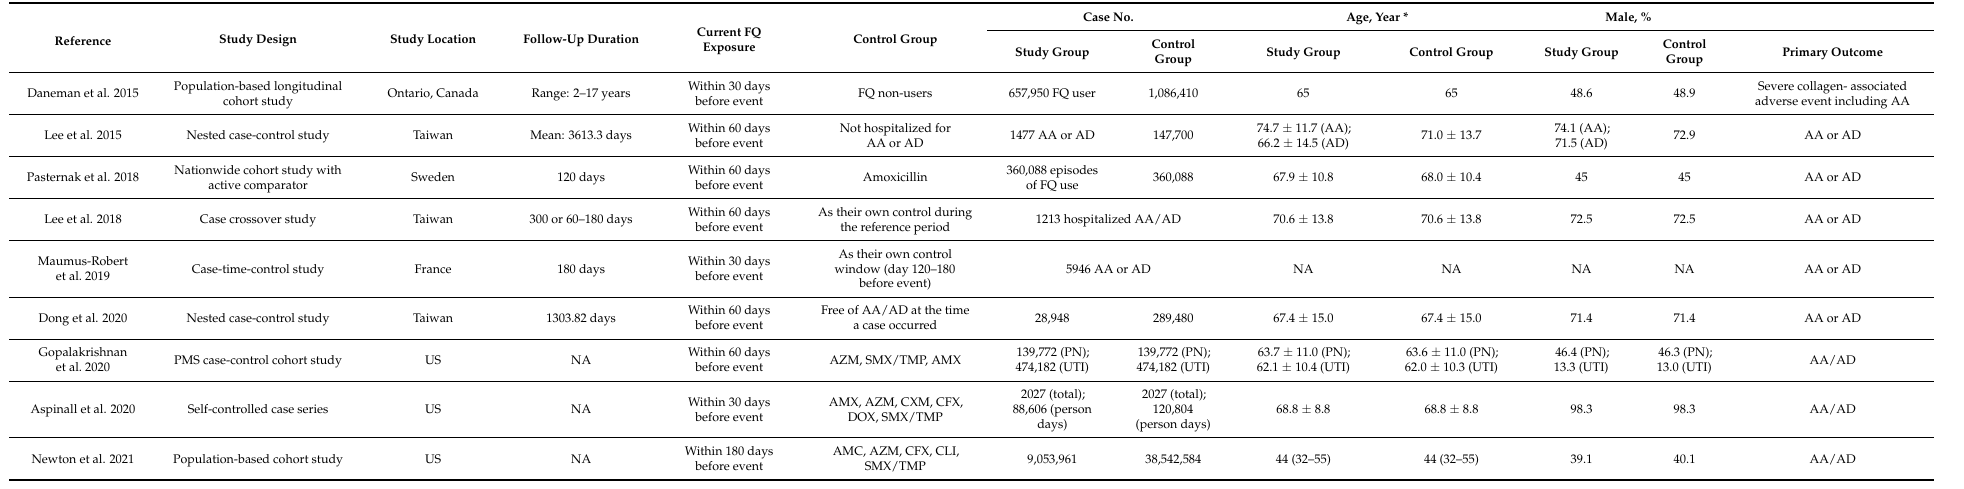
Table 1. The characteristics of included